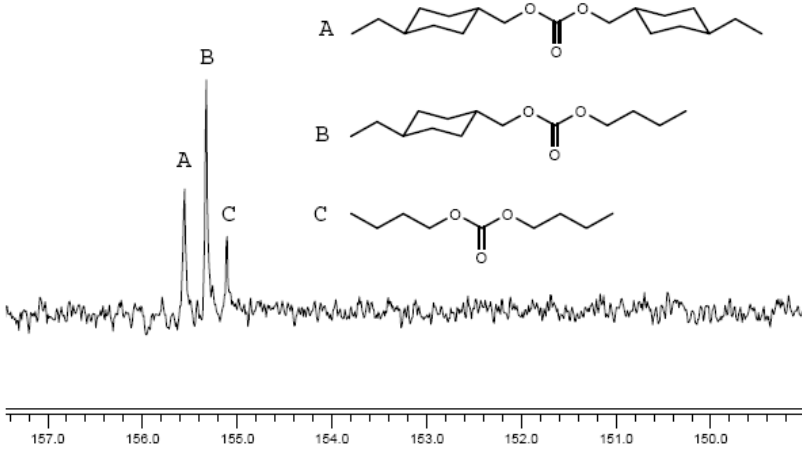
Figure 4. 13 C-NMR peaks of C=O observed in the spectrum of CHDM–BuD